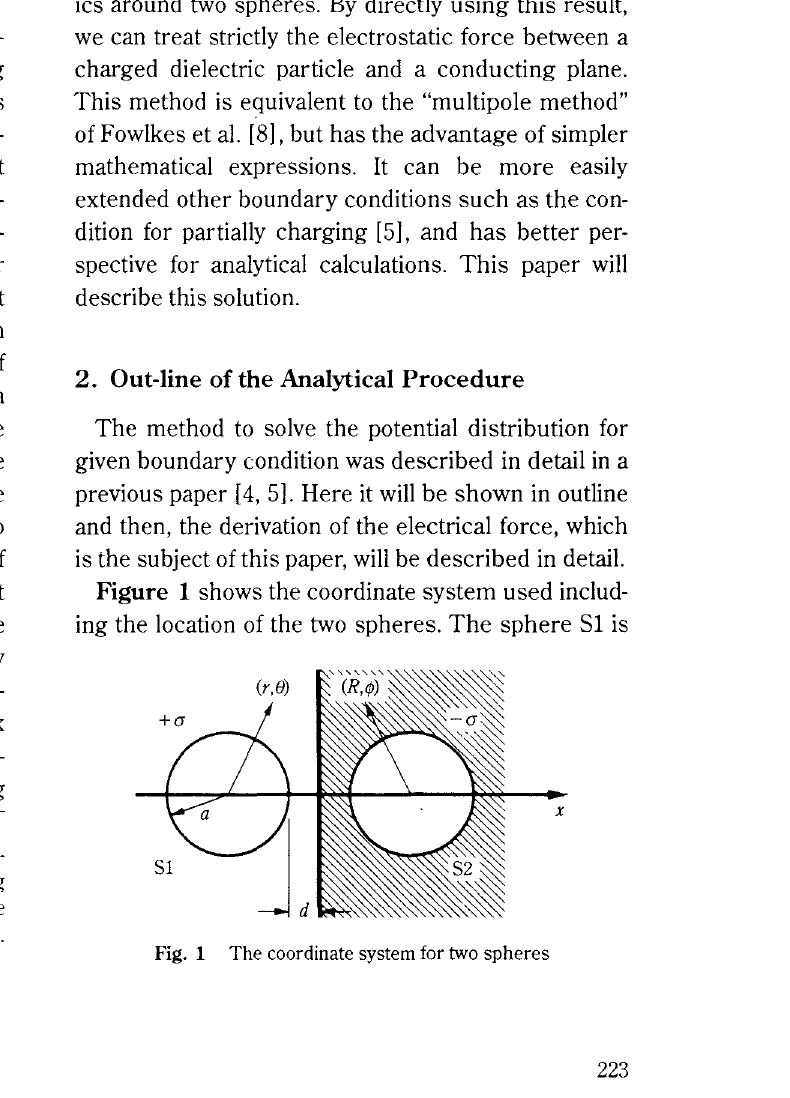
Fig. 1 The coordinate system for two